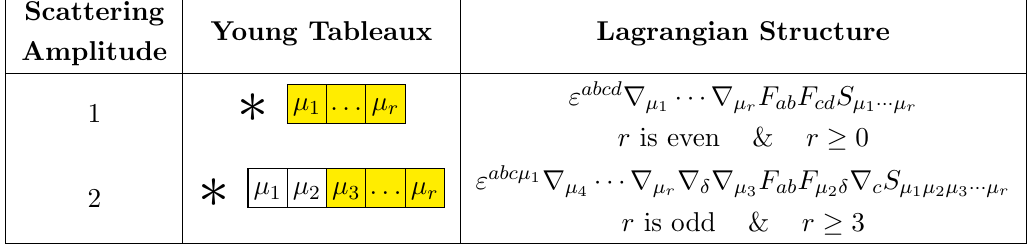
Table 4. Photons , D = 4. The meaning of the symbol